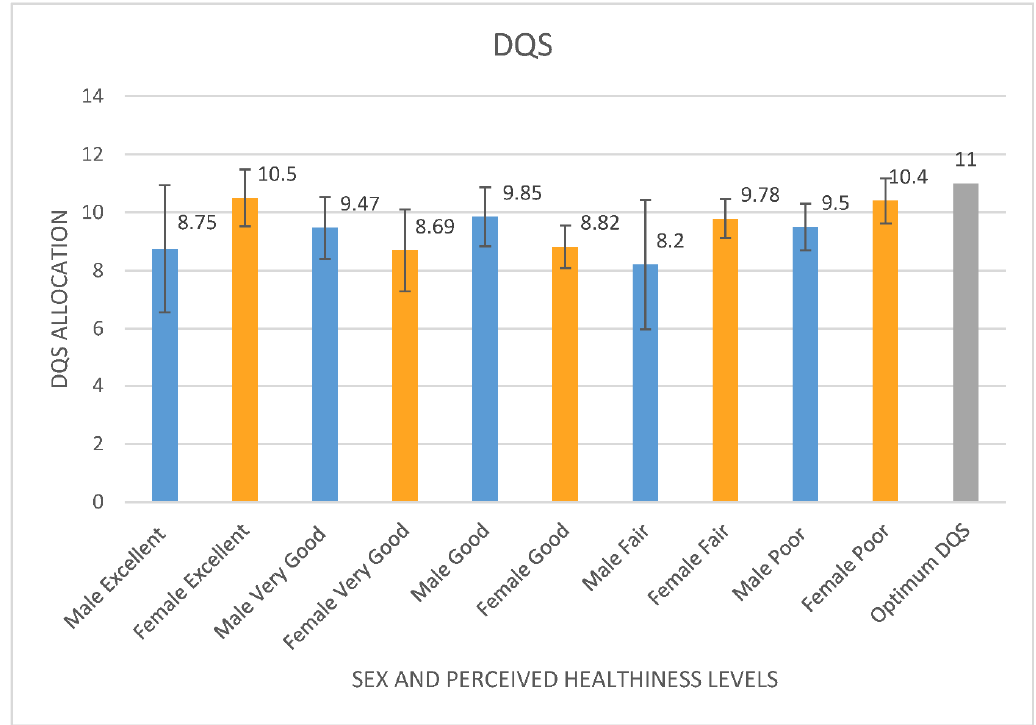
Figure 6. Mean DQS from the Short Form FFQ evaluated using DANTE tool per sex and perceived healthiness levels compared to the optimum DQS.